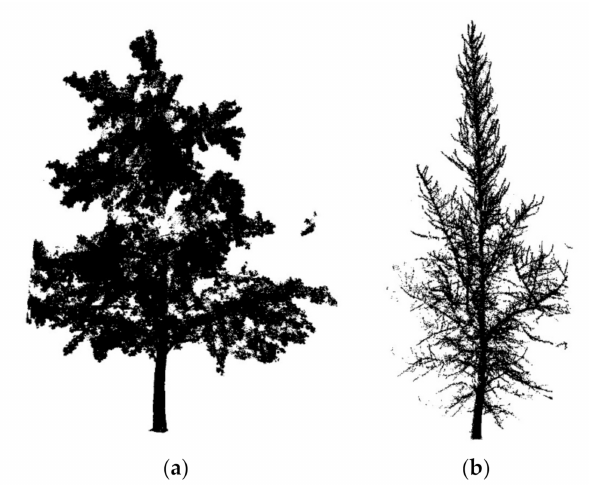
Figure 1. Two sets of point clouds for two ginkgo trees in di ff erent seasons. ( a ) Data 1, ( b ) Data